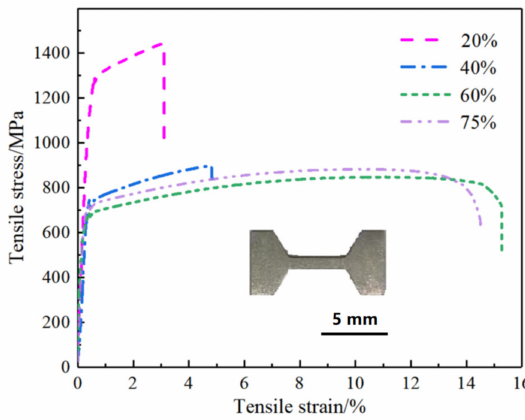
Figure 11. Stress − strain curves at different